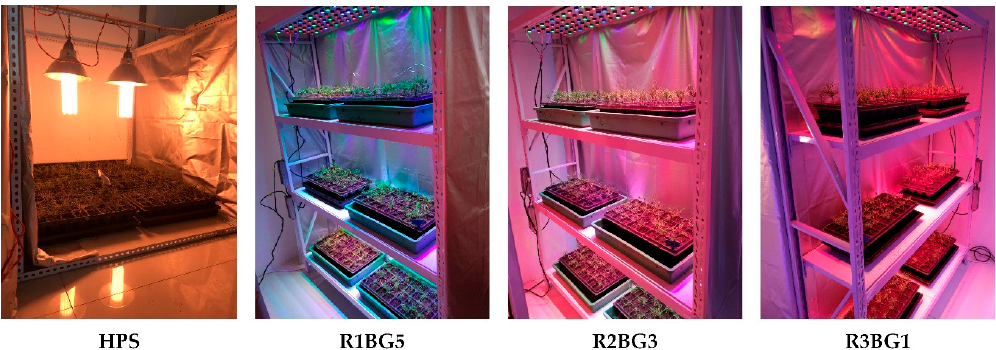
Figure 1. Layout of the culture of Korean pine ( Pinus koraiensis ) seedlings under three light-emitting diode (LED) spectra. HPS—high-pressure sodium (lamps); R1BG5—electric current for red and combined green and blue LEDs were controlled to be 10% and 50%, respectively; R2BG3—electric current was controlled to be 20% (red) and 30% (green and blue); R3BG1—electric current was controlled to be 30% (red) and 10% (green and blue).